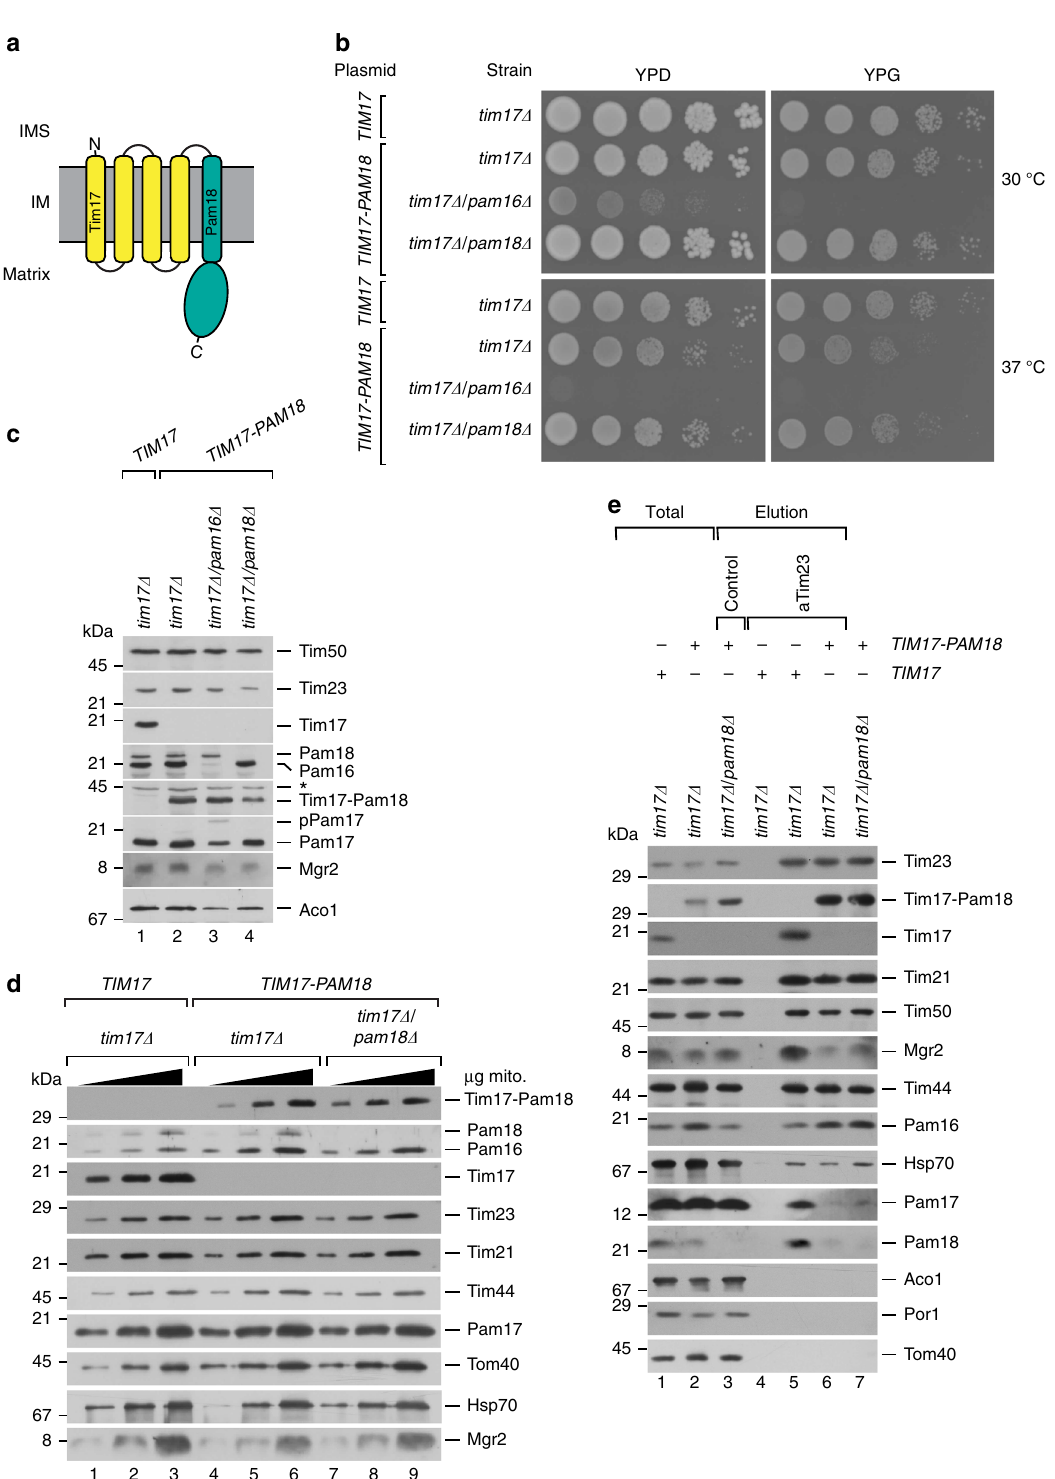
Fig. 1 A functional Tim17 – Pam18 fusion causes reorganization of the TIM23 complex. a Schematic representation of the Tim17 – Pam18 fusion. N, N terminus; C, C terminus; IMS, intermembrane space; IM inner membrane. b Tenfold serial dilutions of wild-type and indicated Tim17 – Pam18 strains were spotted on YPD and YPG plates and grown at indicated temperatures. c Western blot analysis of cell lysates from wild-type and Tim17 – Pam18 strains. Asterisk, unspeci fi c signal of antibody. Tim17 – Pam18 protein was detected using Pam18 antibody. d Western blot analysis of steady-state protein using isolated mitochondria (5, 10, and 20 µ g). e Digitonin-solubilized mitochondria were subjected to anti-Tim23 immunoisolation and samples were analyzed by western blotting. Total, 10%; elution,